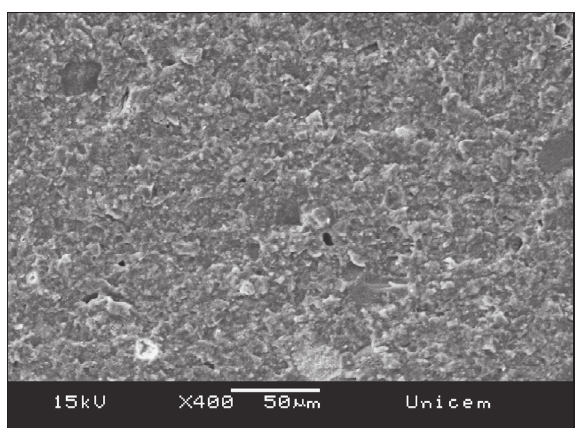
Figure 2 - Cohesive failure within the Clearfil SA Cement (type 1; original magnification 400 × ).